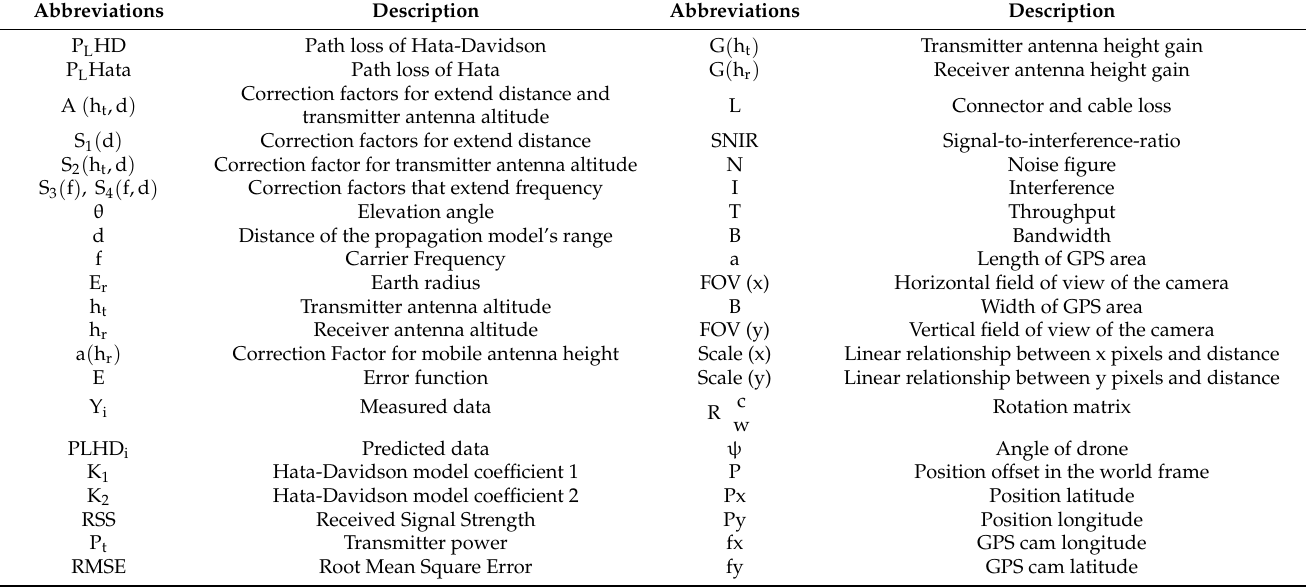
Table 1. List of